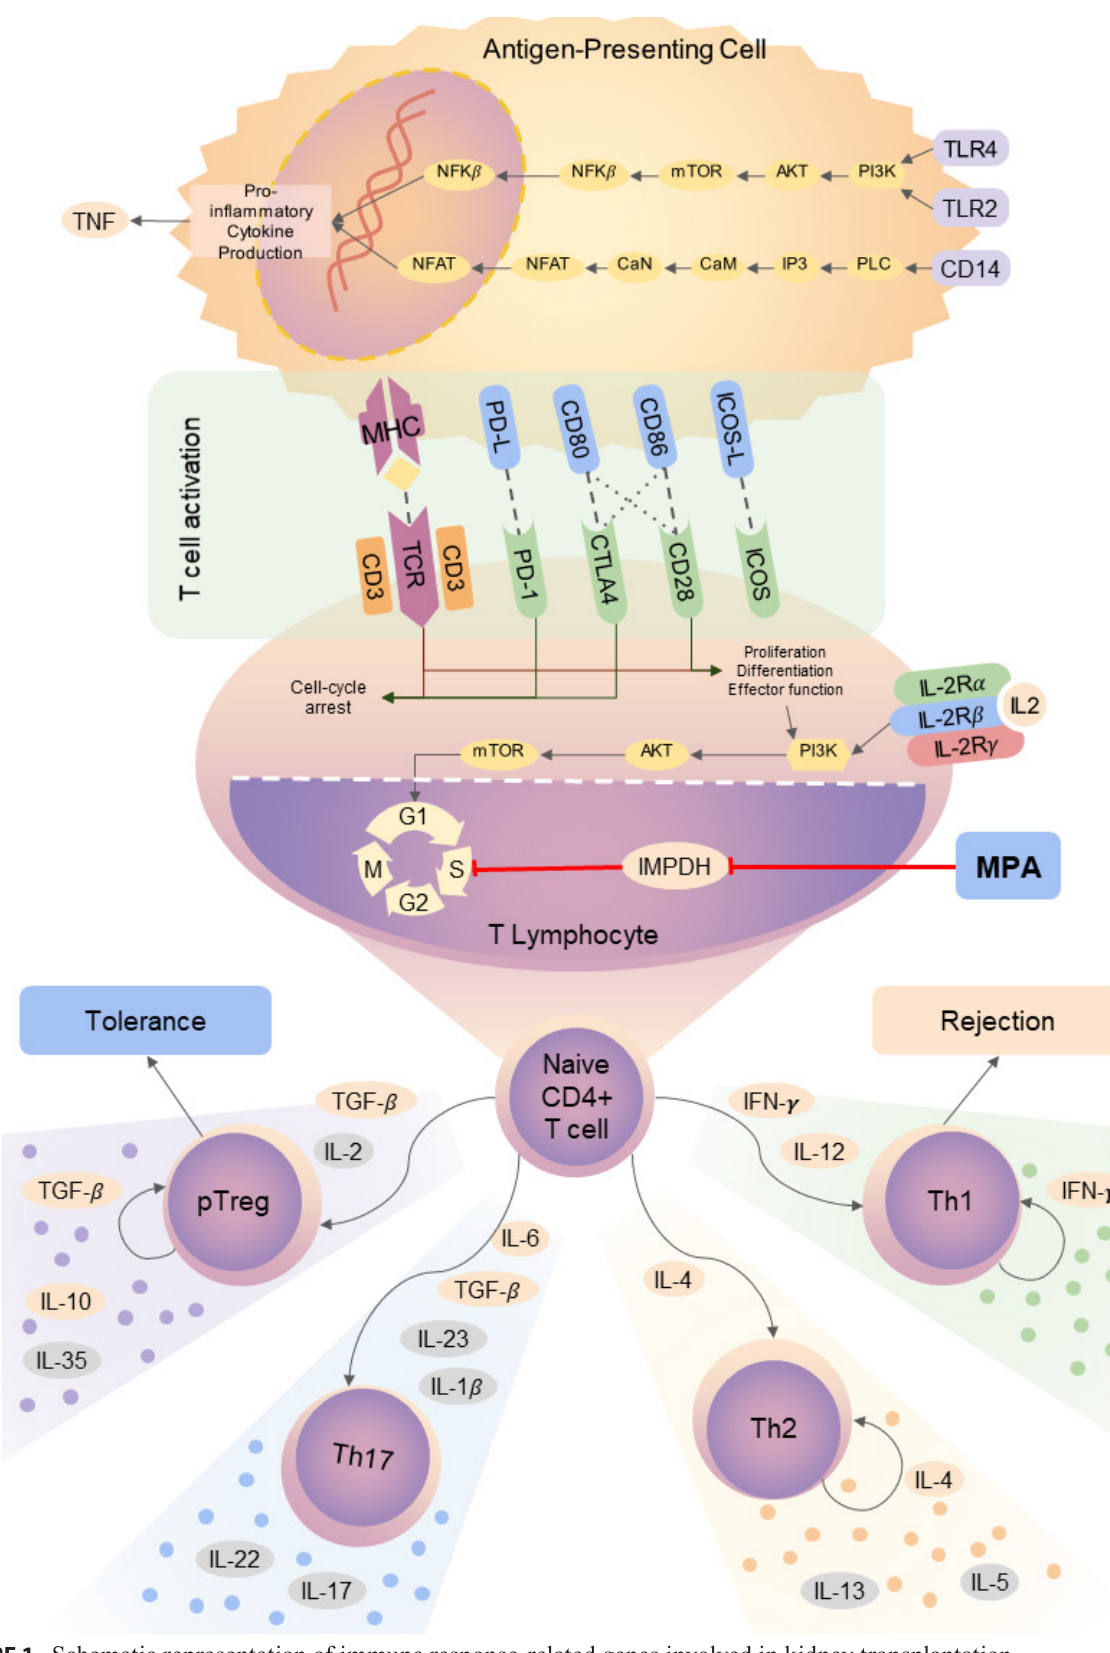
FIGURE 1 - Schematic representation of immune response-related genes involved in kidney